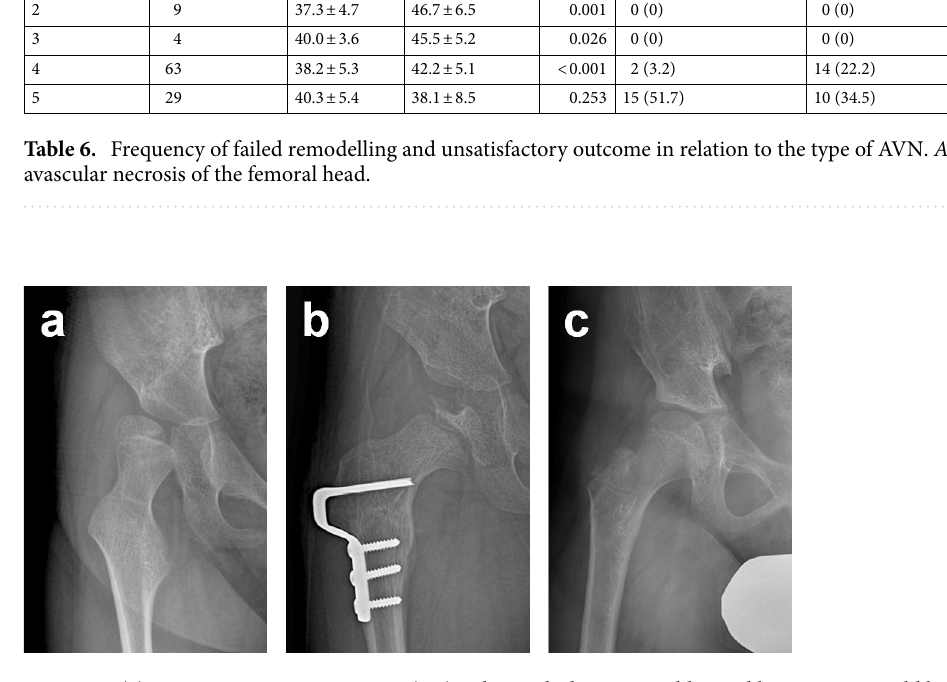
Figure 2. ( a ) Preoperative anteroposterior (AP) radiograph showing a subluxated hip in a 6-year-old boy. ( b ) AP radiograph showing Type 3 AVN developed after open reduction and varus derotational osteotomy of the proximal femur (VDRO). ( c ) At 6 years after surgery, the femoral head was noted to be remodelled without